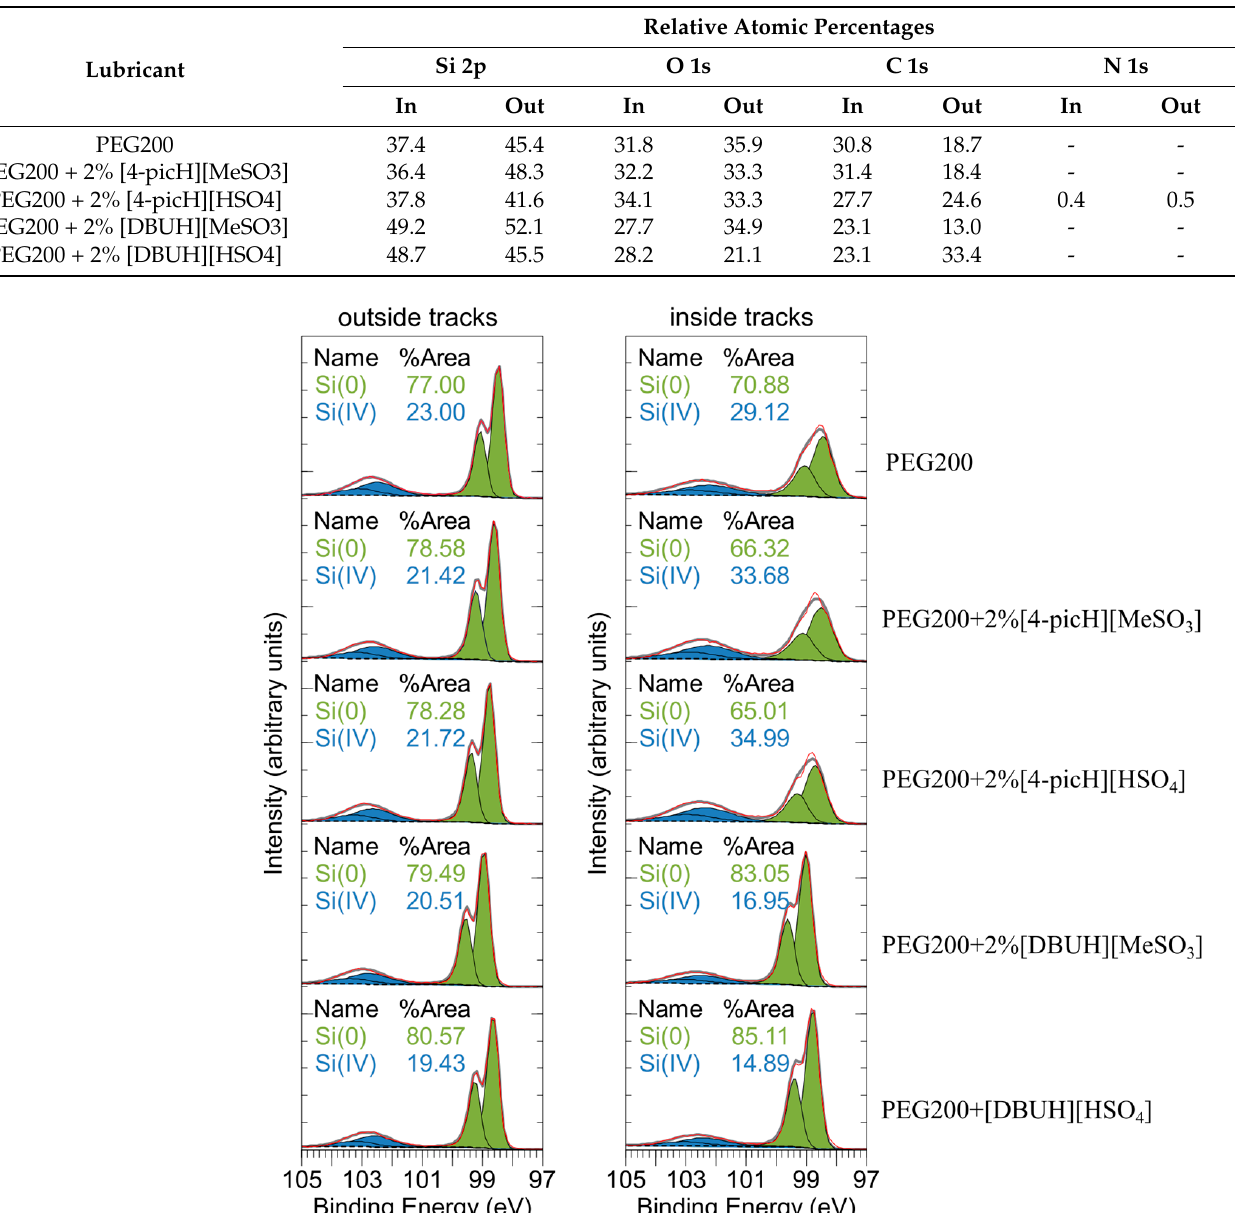
Table 2. Relative surface atomic concentrations inside and outside the wear tracks (shown in Figure 6).